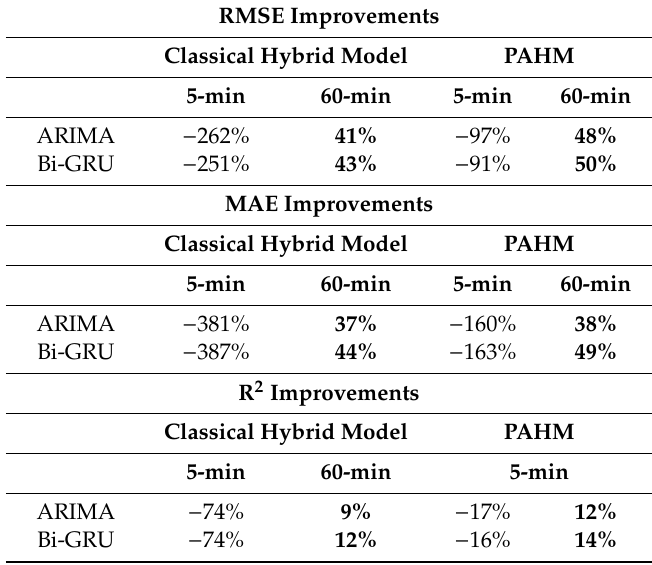
Table 9. Performance improvements by the hybrid models as compared to the single models. RMSE